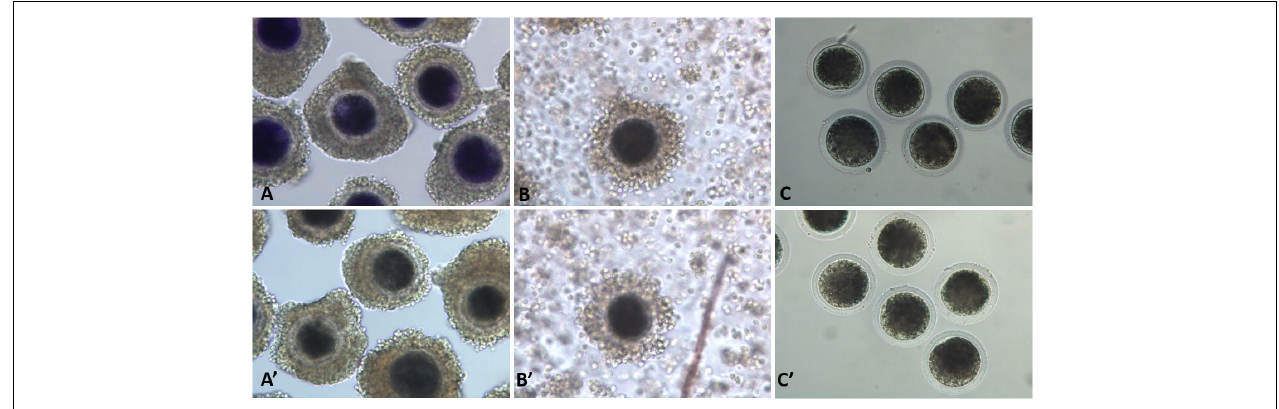
FIGURE 1 | Porcine oocytes after brilliant cresyl blue (BCB) staining. BCB − stained (BCB + ; A–C ) and non-stained (BCB − ; A (cid:48) –C (cid:48) ) oocytes in the immature cumulus–oocyte complexes (COCs; A,A (cid:48) ), mature COCs ( B,B (cid:48) ), and denuded mature oocytes ( C,C (cid:48)